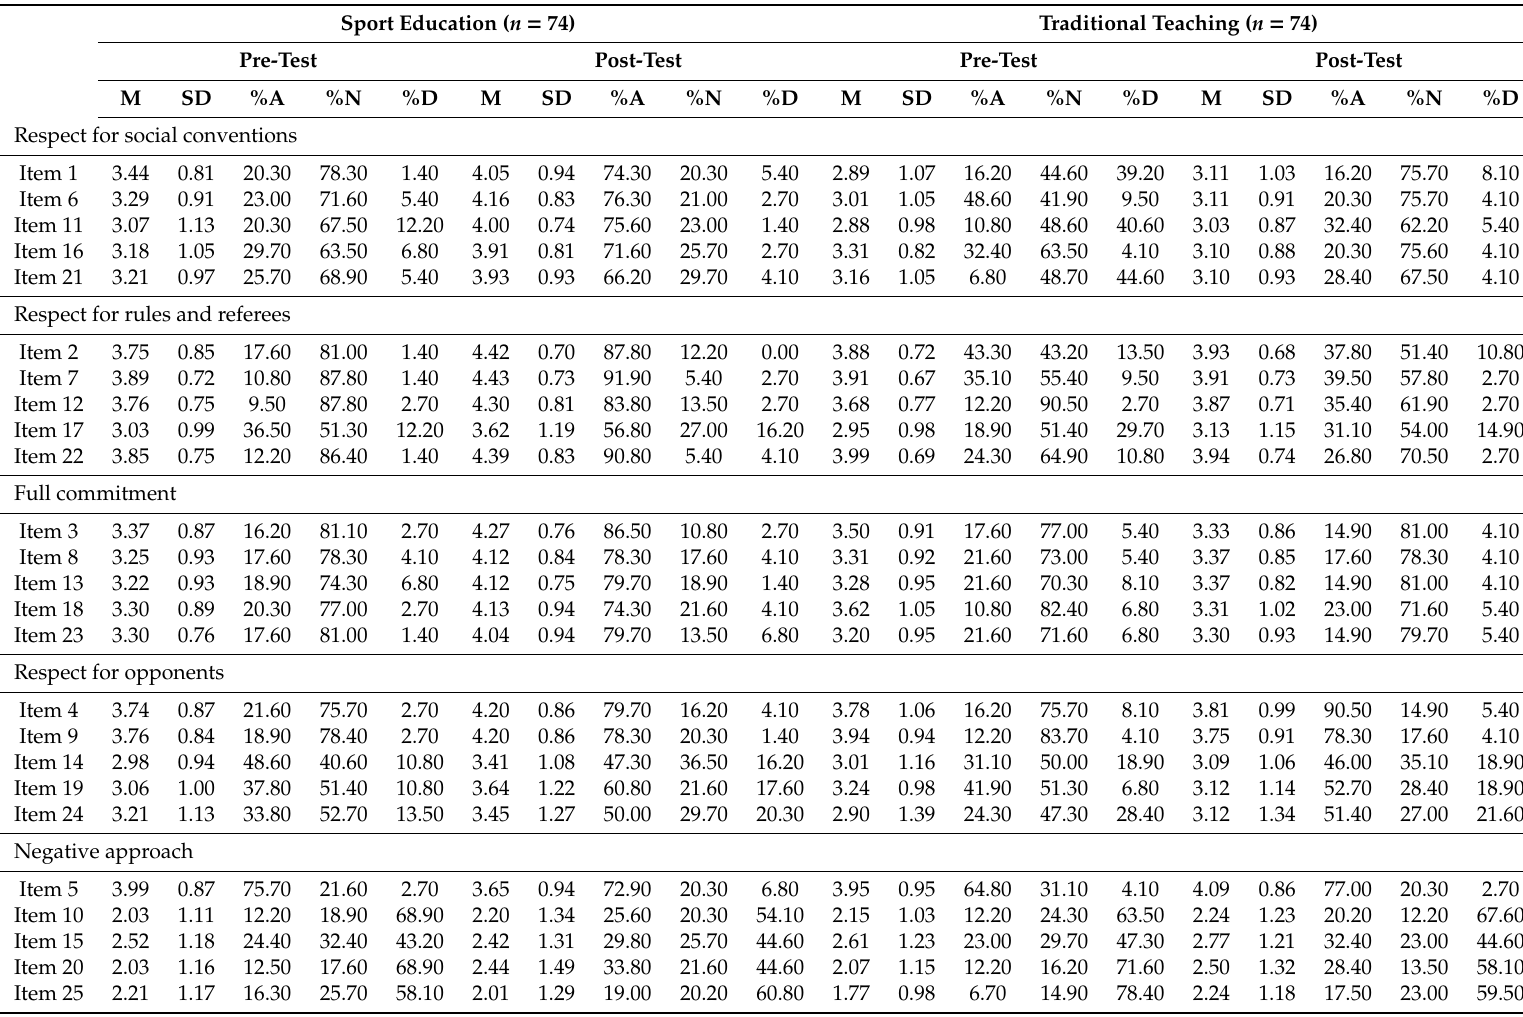
Table 3. Descriptive statistics for each item according to the Sport Education and Traditional Teaching